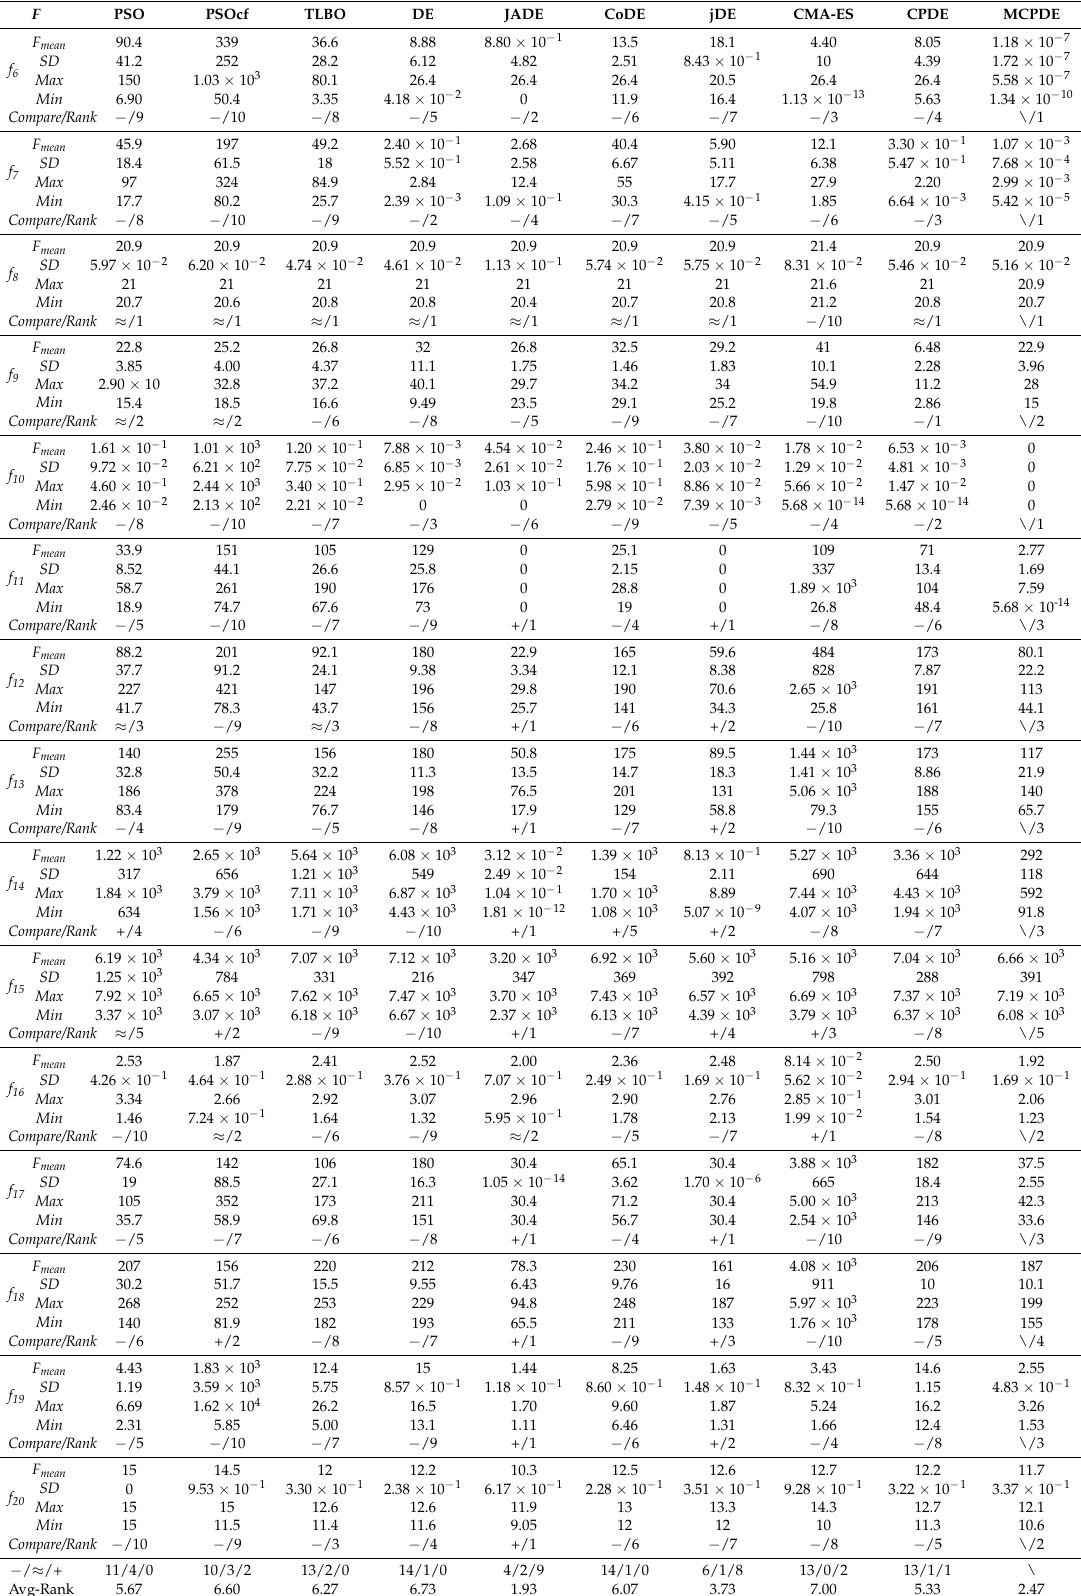
Table 4. Experimental results of PSO, PSOcf, TLBO, DE, JADE, CoDE, jDE, CMA-ES, CPDE and MCPDE over 30 independent runs ON f 6 – f 20 test functions with 30 D